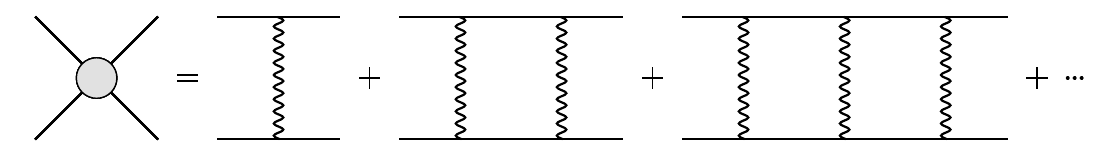
Figure 1 . Feynman diagrams in the fundamental theory for wino-wino scattering through the exchange of electroweak gauge bosons. The solid lines are neutral winos or charged winos, and the wavy lines are electroweak gauge bosons. If M is su(cid:14)ciently large and the winos are nonrelativistic, these ladder diagrams must be summed to all orders.